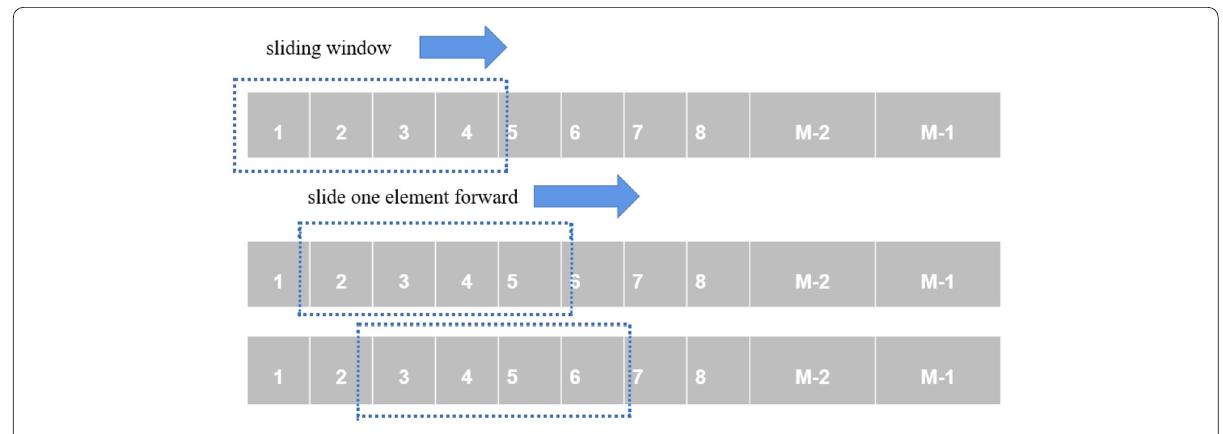
Figure 1 The demonstration of the sliding